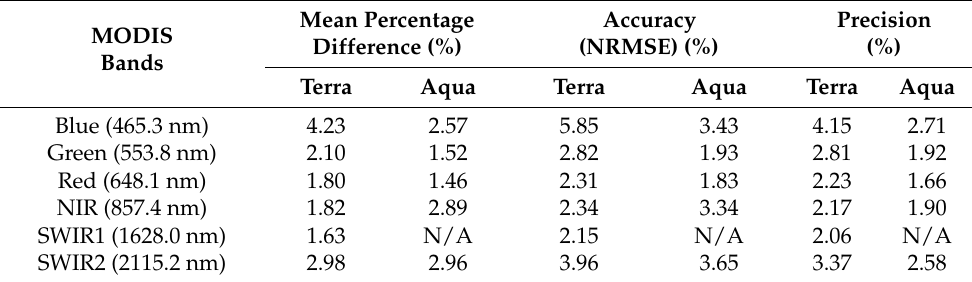
Table 8. Systematic offsets and random uncertainties between absolute calibration model predictions and MODIS